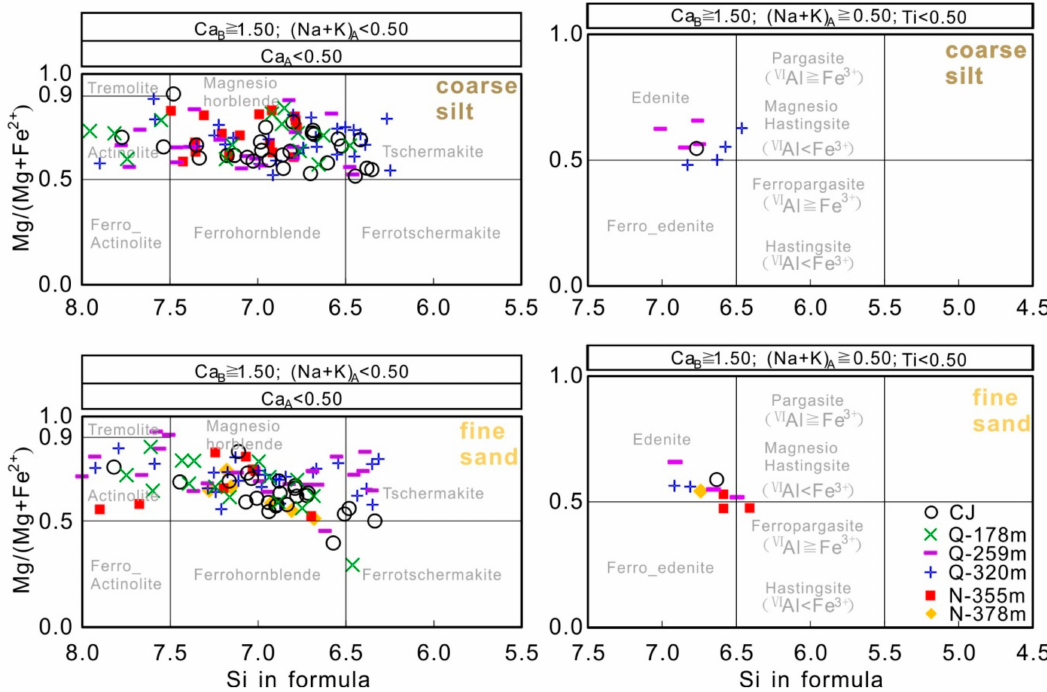
Figure 5. Amphibole classification diagrams for Core LQ24 and the modern Changjing River. CJ = Changjiang, N = Pliocene, Q = Pleistocene. Ca-amphibole classification was performed according to